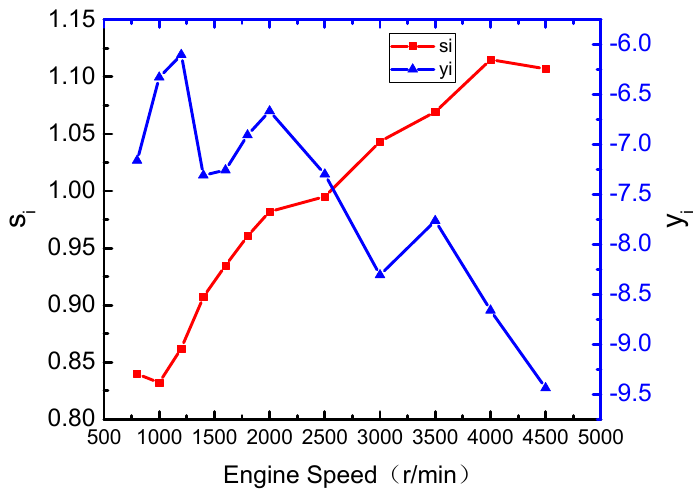
- y alone with the intake pressure. i man i